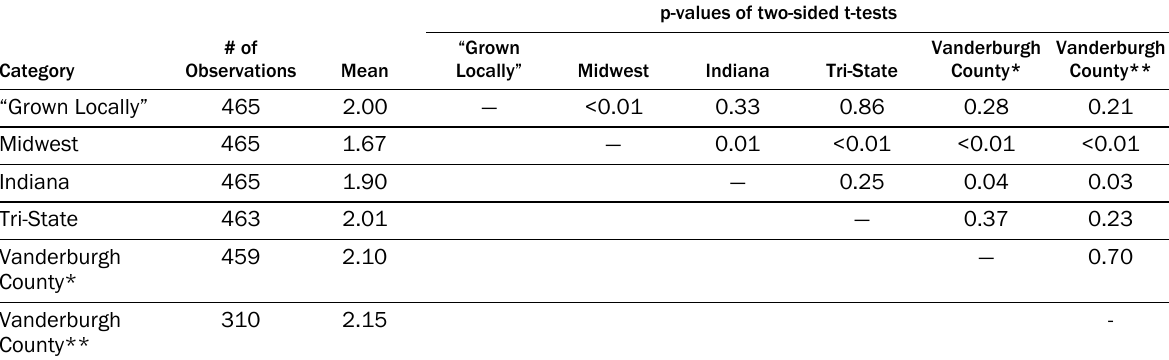
p-values of two-sided